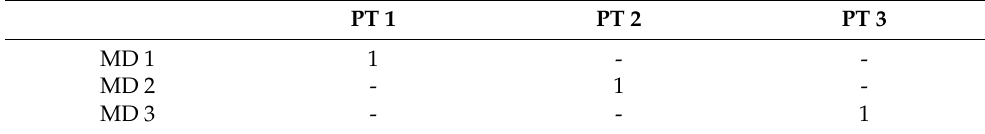
Table 3. Quantitative relationships between modules and parts.